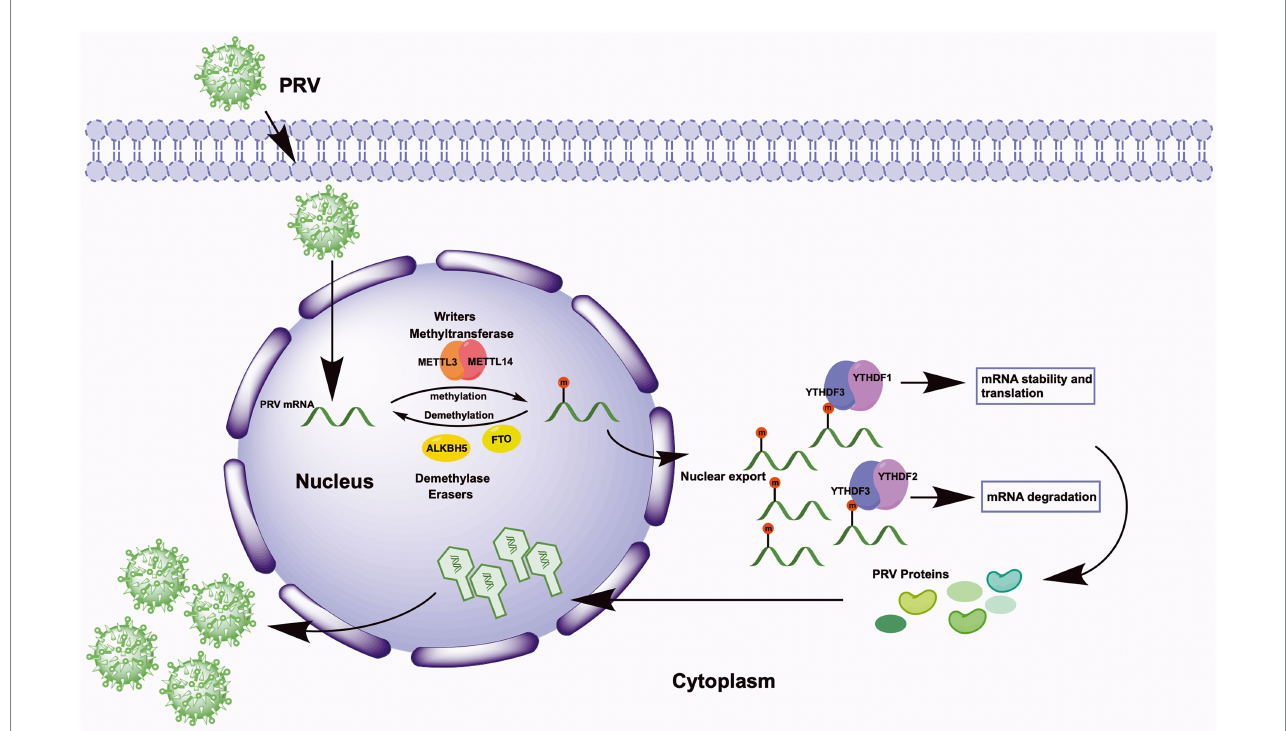
FIGURE 9 Schematic representation of m 6 A regulation of PRV replication. Upon viral infection, virions first attach to the host cell surface, subsequently enter the cell, and finally the viral genome is released into the host cell nucleus. In the nucleus, the methyltransferases METTL3/14 co-induce the methylation of multiple viral mRNAs, whereas the demethylases FTO and ALKBH5 regulate the demethylation process. The methylation of viral mRNA promotes its own nuclear export. In the cytoplasm, YTHDF1 and YTHDF3 synergistically promote mRNA stability and translation, and YTHDF3 cooperates with YTHDF2 to promote mRNA degradation. Ultimately, the expression of PRV proteins is promoted by the cooperation of YTHDF1/2/3, and these products are transported back into the nucleus, where they complete the viral nucleocapsid assembly and eventually release more viral